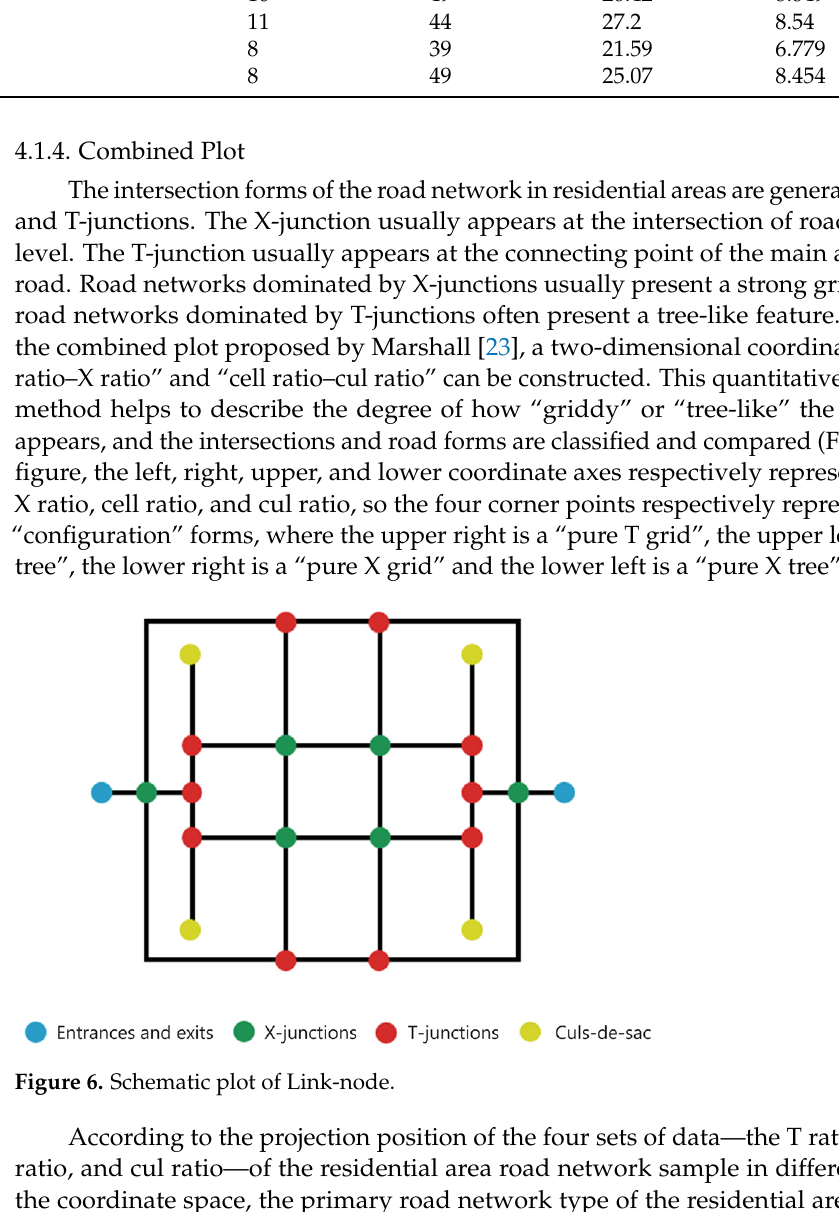
Figure 7. Intersection form of the road network.